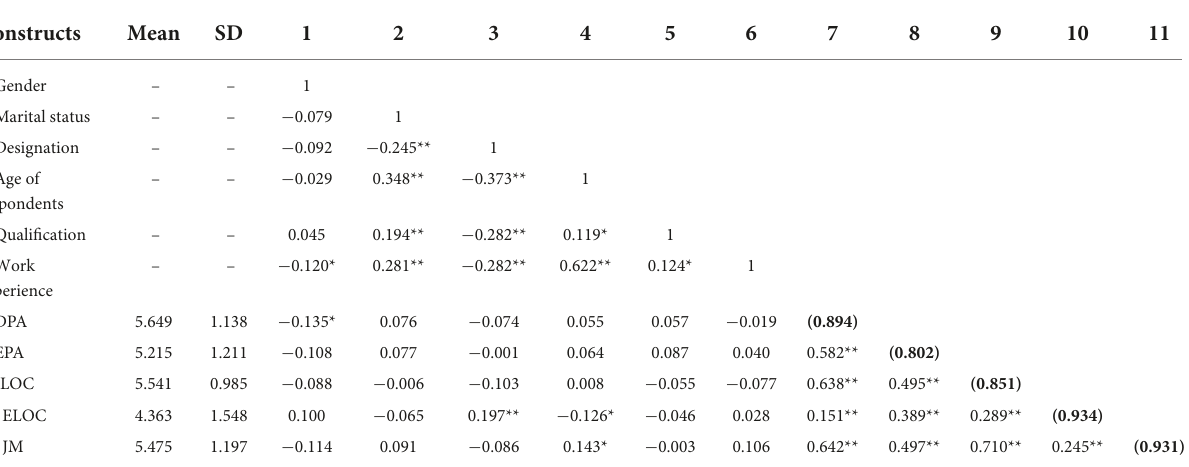
TABLE 4 Mean, standard deviation, and correlation matrix.